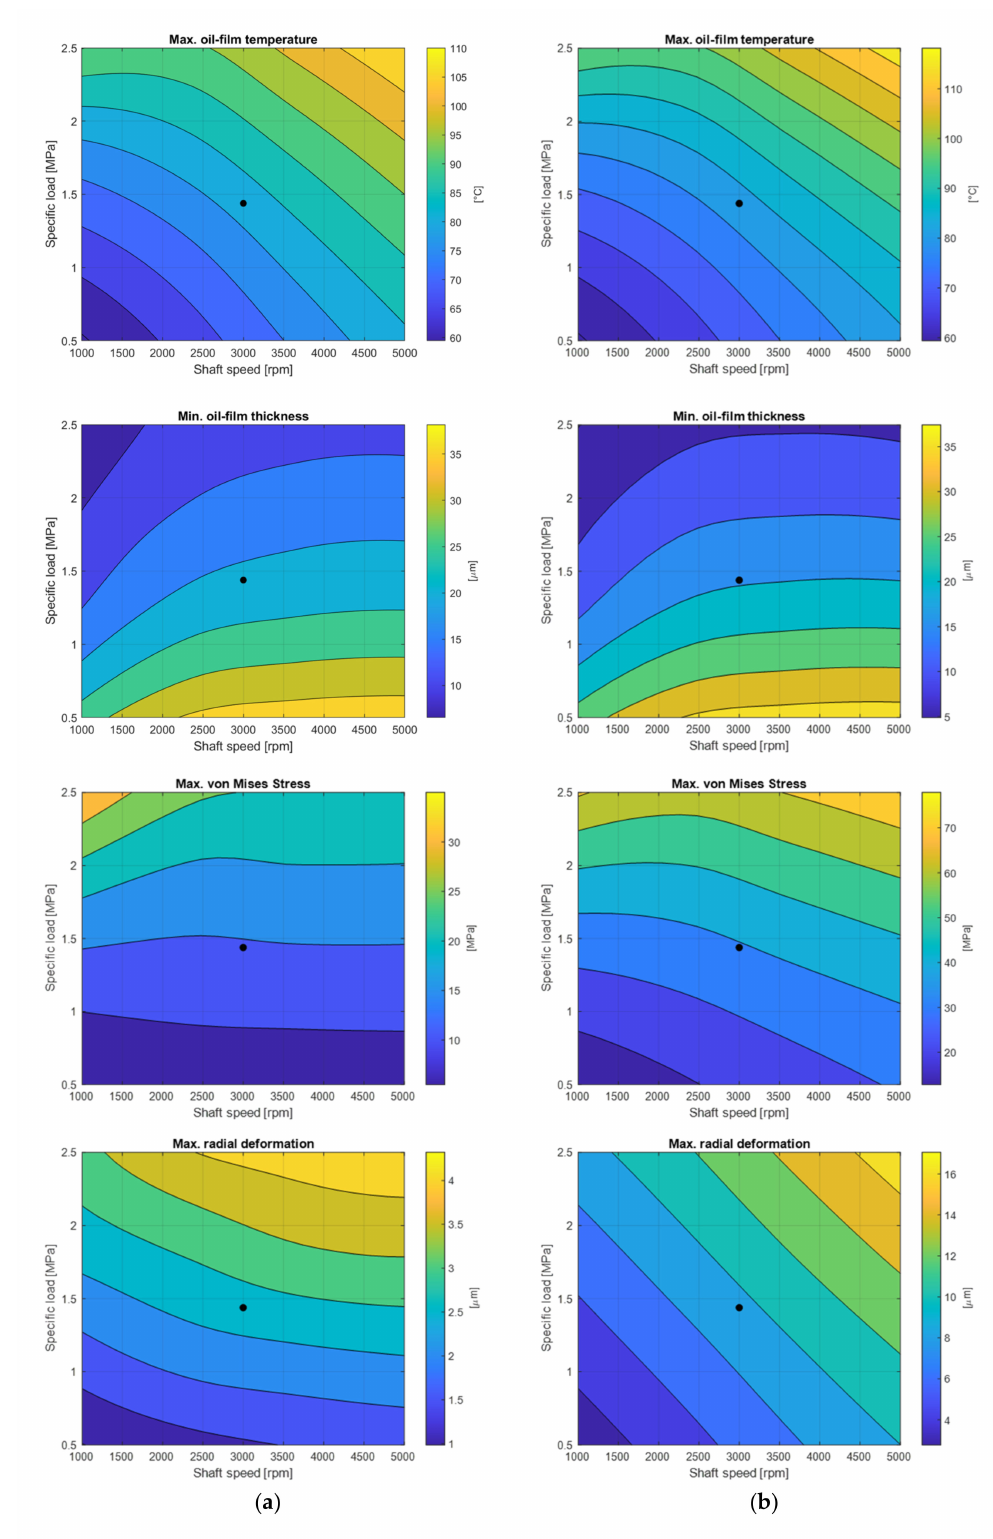
Figure 8. Maps of maximum temperature, minimum oil-film thickness, maximum von Mises stress and maximum radial deformation. ( a ) Babbitt lining and ( b ) PEEK